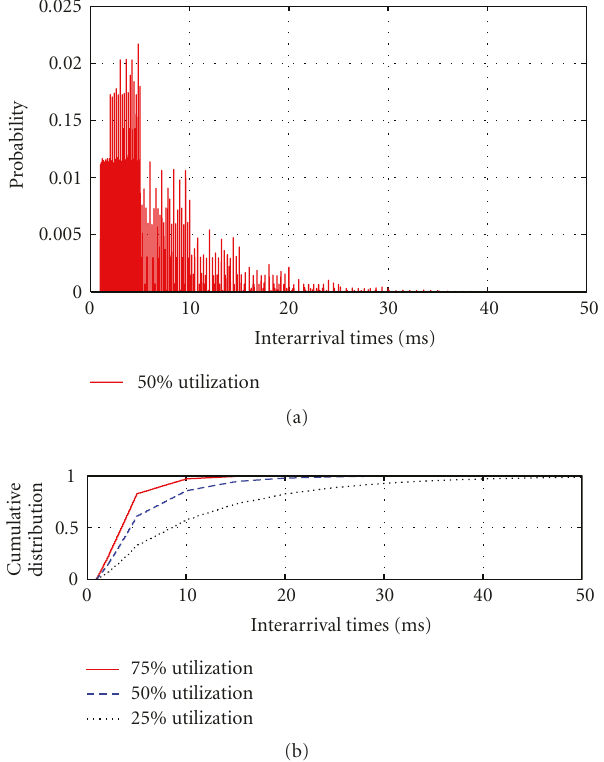
Figure 11: (a) PDF of interarrival times for WisperNet. (b) Corresponding CDF.